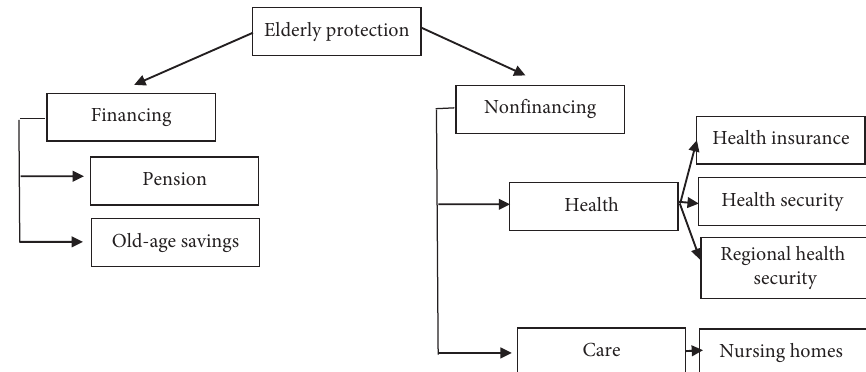
Figure 1: Elderly social protection scheme in Indonesia (source: Bappenas,